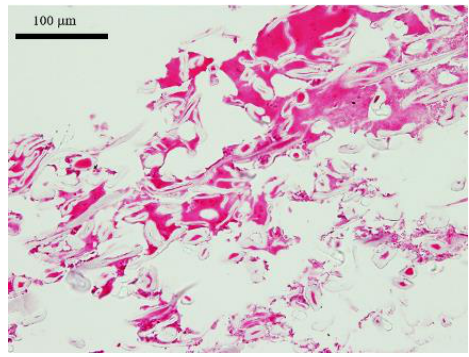
Figure 8. HE assessment of NPWT dressing. On postoperative day 3, a part of the NPWT dressing was obtained for HE stain assessment during its first dressing change. The dressing contained inflammatory cells and blood cells, but no cells were seen as being leaked from the skin grafts.